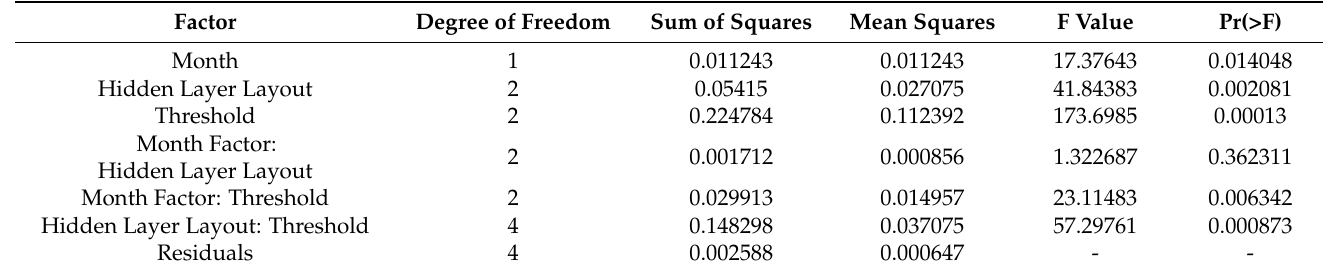
Table 8. ANOVA table of nationwide PM 2.5 prediction